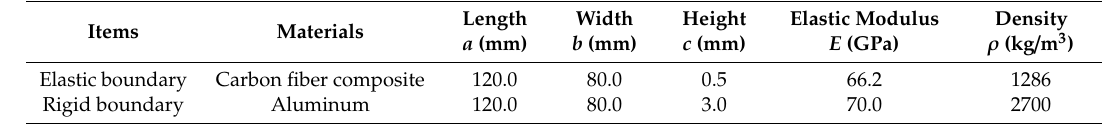
Table 1. The detailed parameters about the